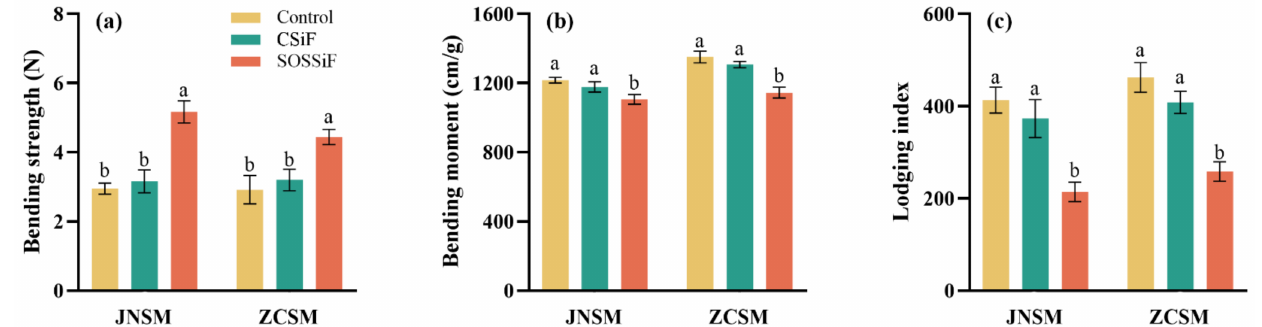
Figure 7. Effect of different Si treatments on stem mechanical properties. ( a ) bending strength, ( b ) bending moment, ( c ) lodging index. Different small letters above the histogram of the same rice variety indicated significant differences.